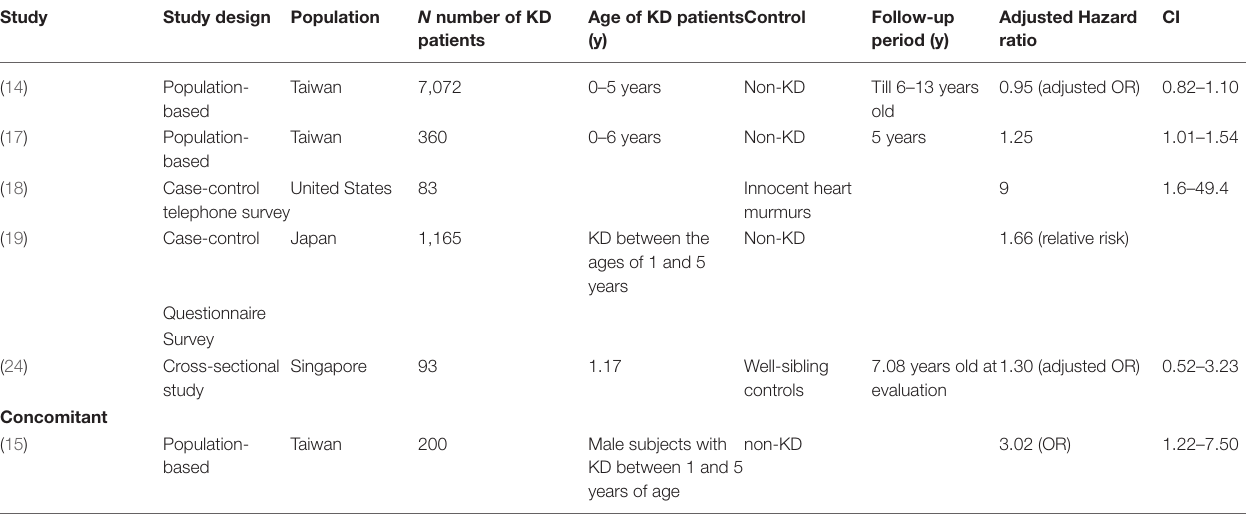
TABLE 3 | Effect of Kawasaki disease on atopic dermatitis.